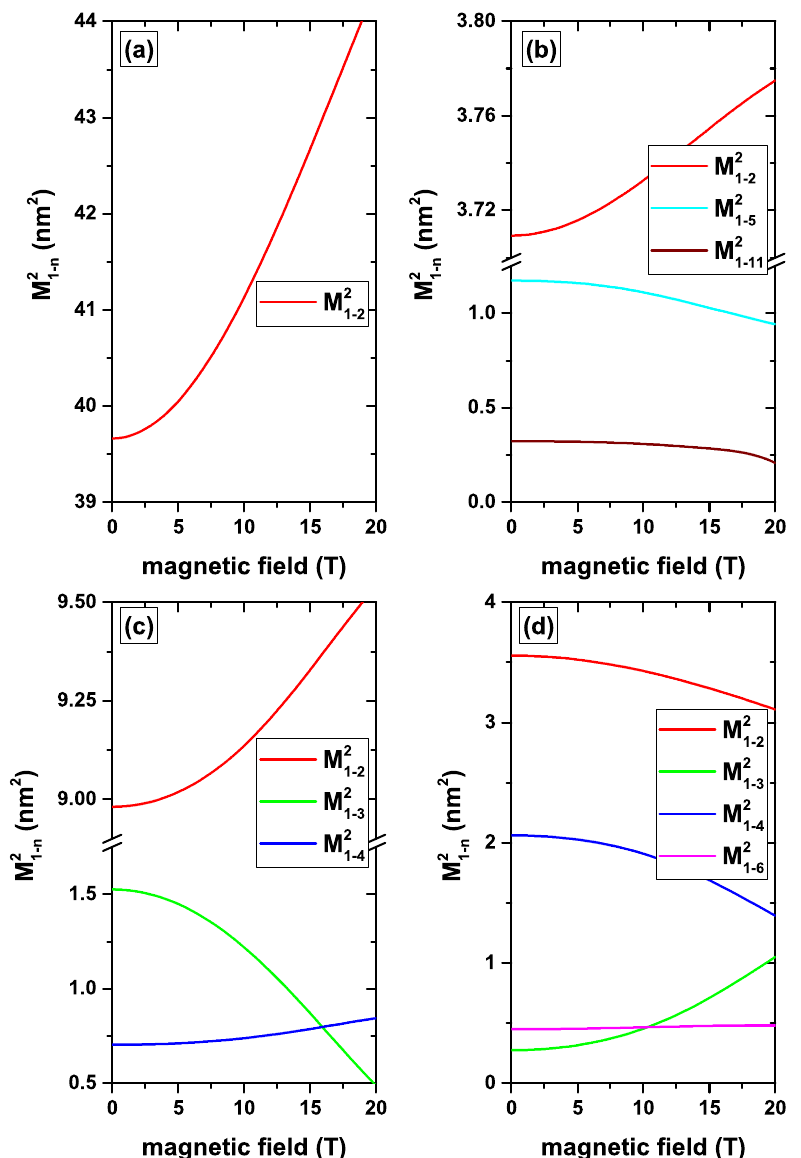
Figure 9. (color online) The squared matrix elements of the transitions from the ground state to the first fourteen excited states with l = 0 ( | 1 (cid:105) → | n (cid:105) , with n = 2,3, . . . ,15) for a confined electron in a CdS/ZnS spherical QD as functions of the MF. Results are without ( a , c ) and with ( b , d ) on-center donor impurity, with R 1 = 20nm and R 2 = 30nm. Calculations are for zero EF ( a , b ) whereas in ( c , d ) the results are for F = − 20kV/cm, z -directed EF. In Figure 10, where only the | 1 (cid:105) → | 2 (cid:105) transition is considered, there is a drop in the magnitude of the resonant peak in the total absorption coefficient ( α ) which comes from the decrease in the transition energy as the radius of the QD increases, as can be seen from Figure 2. This occurs despite the fact that M 2 increases or decreases with the radius of 1 − 2 the QD, as seen in Figure 6a,b, respectively. The magnitude of the resonant peak in the α -coefficient is dominated by the magnitude of the transition energy. In Figure 10c,d, it can be seen that in the absence (or presence) of the impurity, the magnitude of the relative changes in the refractive index coefficient ( ∆ n ) obeys the behavior of M 2 . That is, 1 − 2